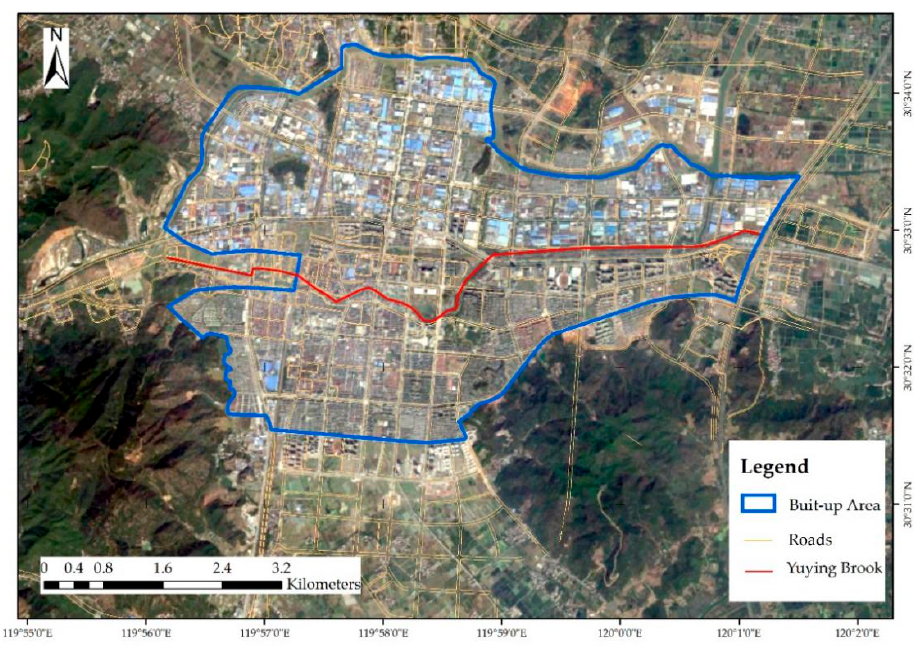
Figure 2. Remote sensing image of built-up area (true color synthesis, 2017-3-11).